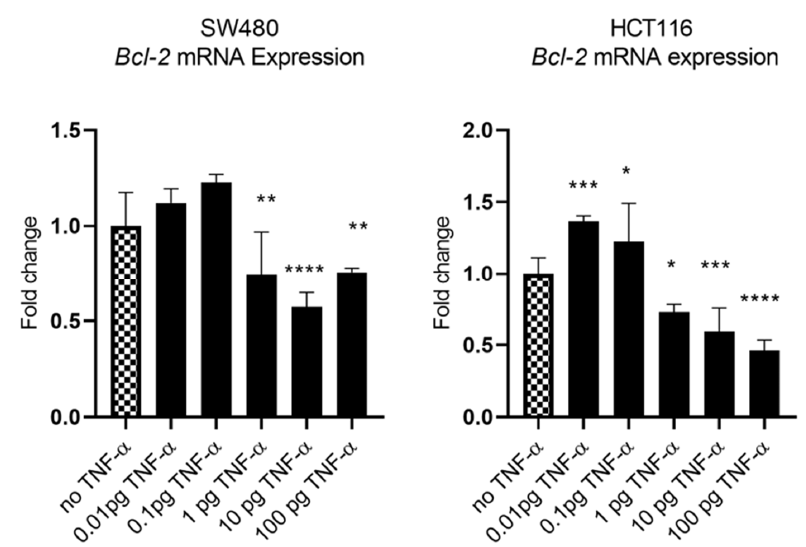
Figure 10. BCL-2 mRNA expression in SW480 and HCT116 cells treated with TNF- α for 24 h. BCL-2 mRNA expression was measured by RT-qPCR. Data were normalised to expression of GAPDH and are shown relative to control (no TNF- α ). Statistically significant differences were calculated using one-way ANOVA with Dunnett’s test (GraphPad Prism 8, * p < 0.05, ** p < 0.01, *** p < 0.001 **** p < 0.0001). Error bars represent the SEM for six replicates and two independent cultures.